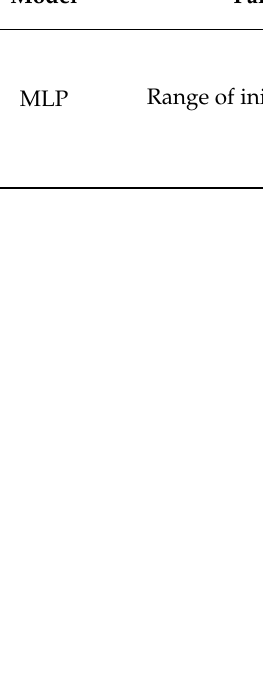
Table 5. Sensitivity analysis of RMLP model